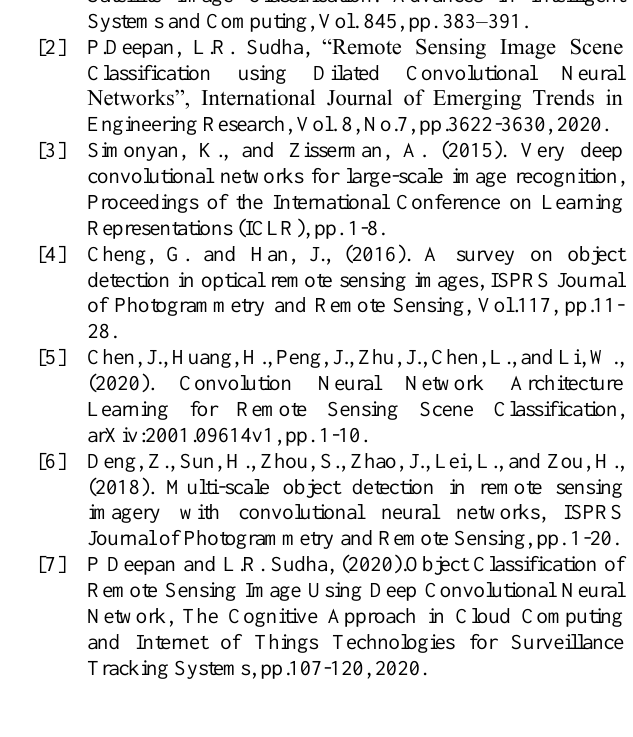
Figure 5. Performance Chart of RSISC-16 Net